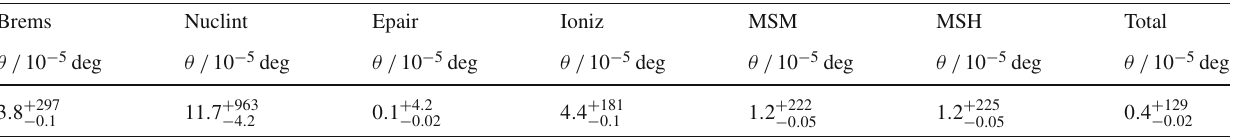
Table 1 The medians of deflections θ per interaction from Fig. 1 are presented for each stochastic interaction type, the two multiple scatter- ing methods, and the total distribution including MSM with the upper